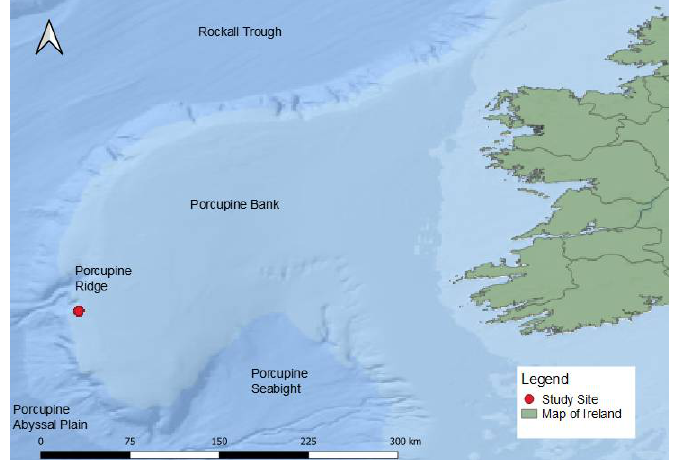
Figure 1. Map showing the position of mooring 6 (latitude 51.72257 and longitude −15.20771) at Porcupine Ridge along the Irish Shelf Edge off western Ireland of the study site.